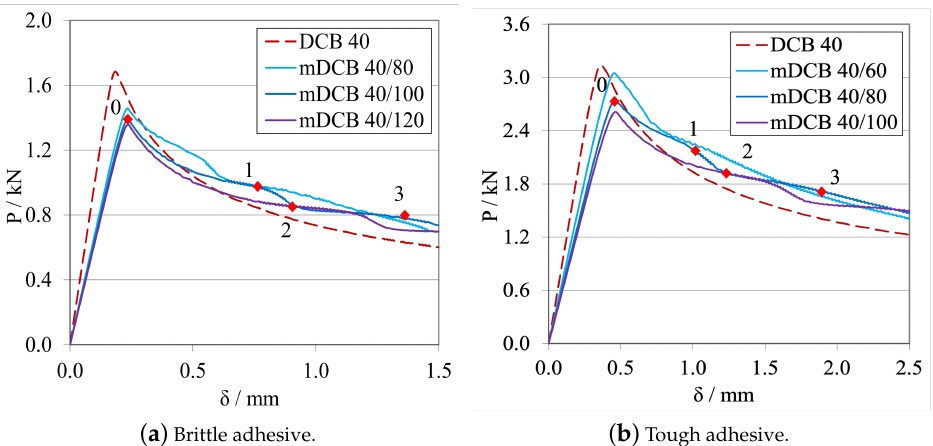
Figure 18. P - δ curves related to a 0 ELS > a 0 mDCB , compared against the correspondent standard DCB. Auxiliary red markers represent the stages of crack evolution for the intermediary dark blue